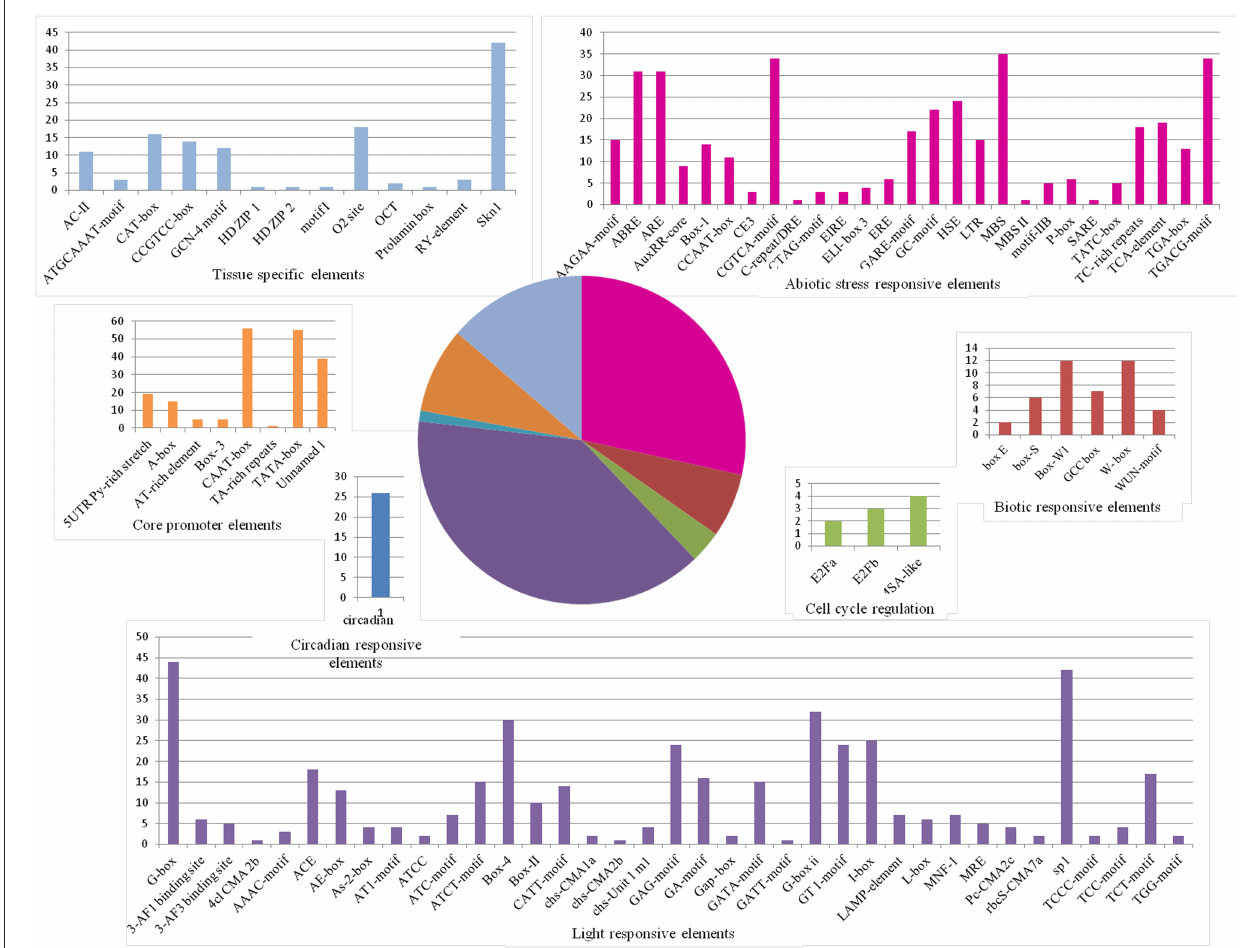
FIGURE 6 | Frequency of cis -regulatory elements in the 1kb promoter of first neighboring target genes of guide OsMYBs in the co-regulatory network. Pie chart depicts the categorized seven types of cis- regulatory elements and the corresponding colored bar chart depicts the occurrence of different cis-